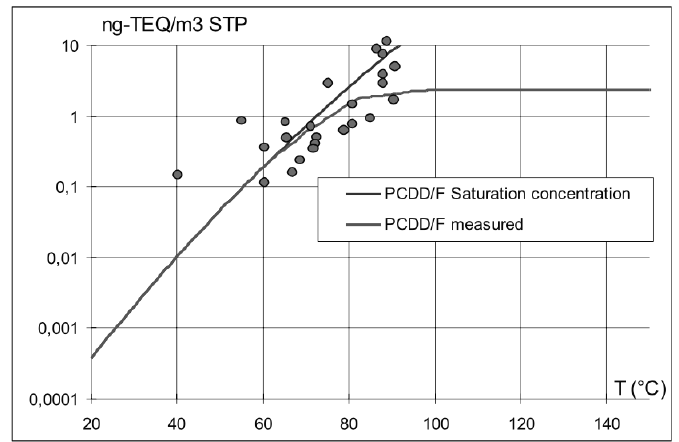
Figure 13. Comparison between the TEQ (toxic equivalent) saturation curve and experimental data from Arcelor Luxembourg.